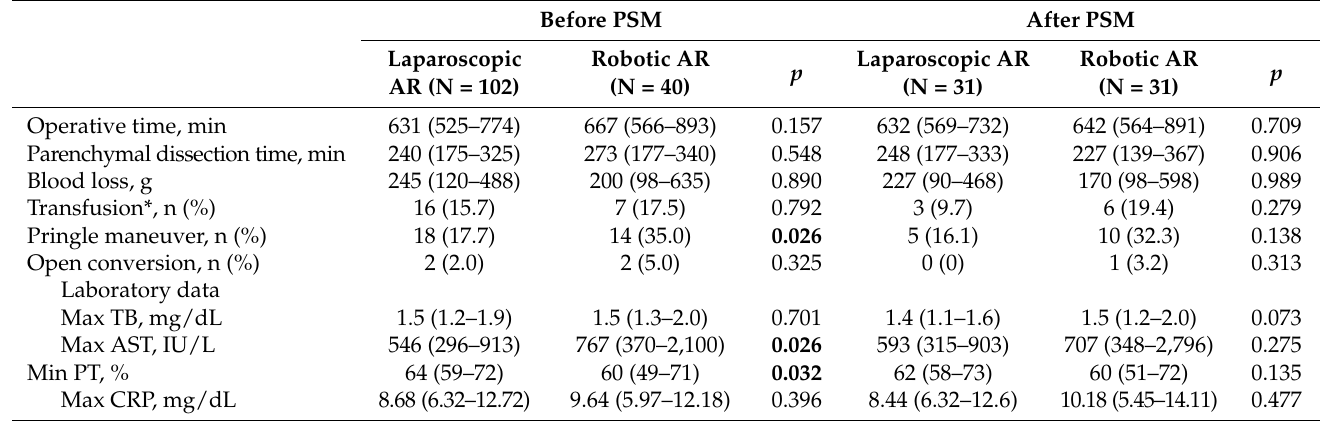
Table 4. Comparison of perioperative outcomes between laparoscopic and robotic AR for